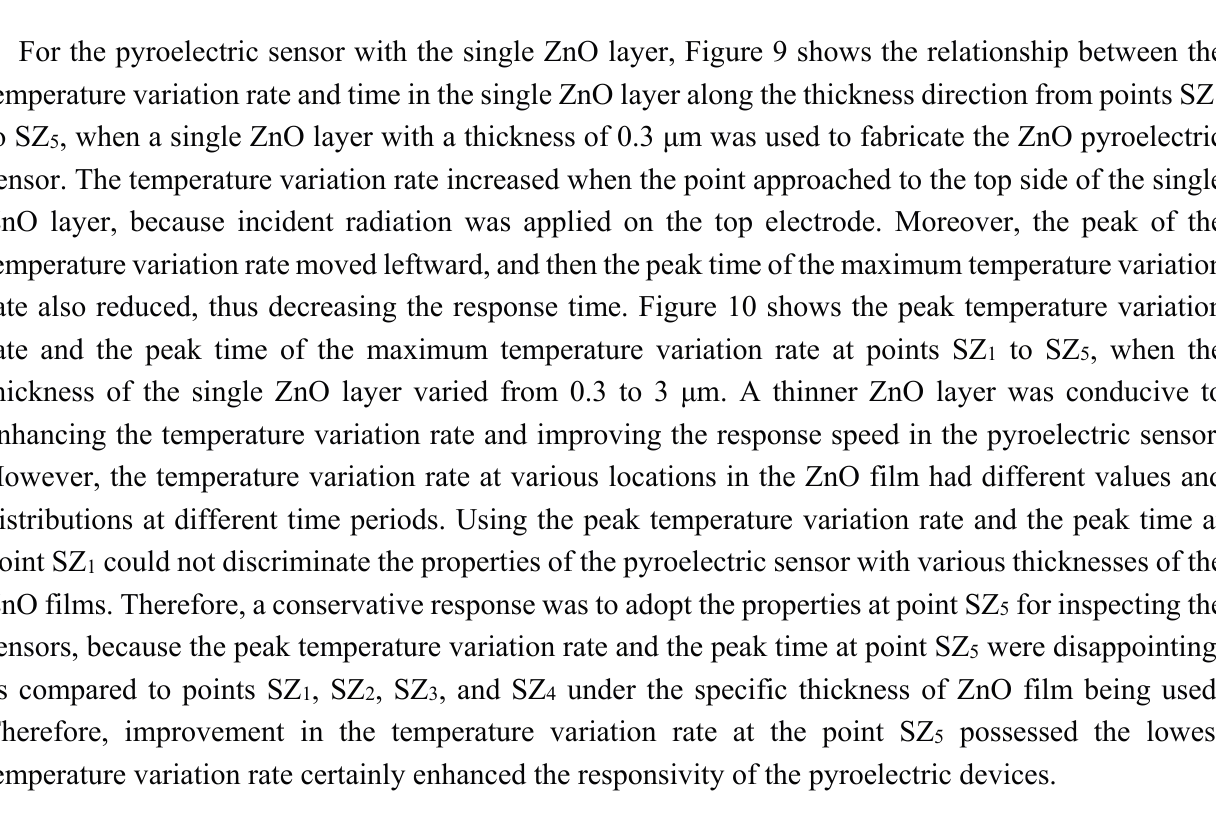
Figure 9. Relationship between the temperature variation rate and time at points SZ 1 to SZ 5 under a 0.3 μ m thick single ZnO